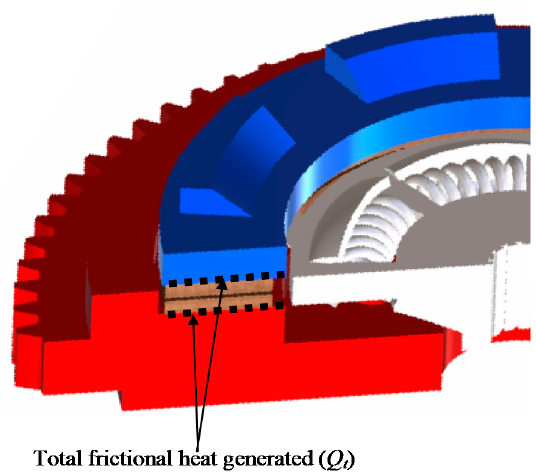
Figure 2. Three-dimensional model of frictional clutch system.